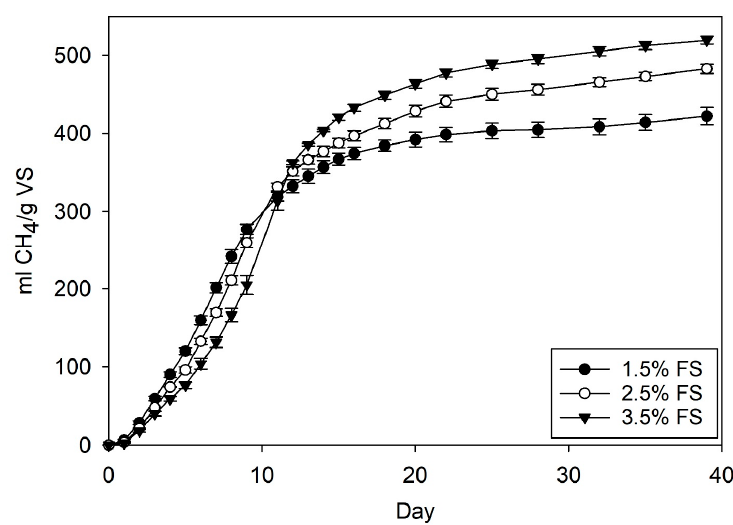
Figure 2. Cumulative methane production using fish sludge as the anaerobic digestion substrate at three different initial solid concentrations.